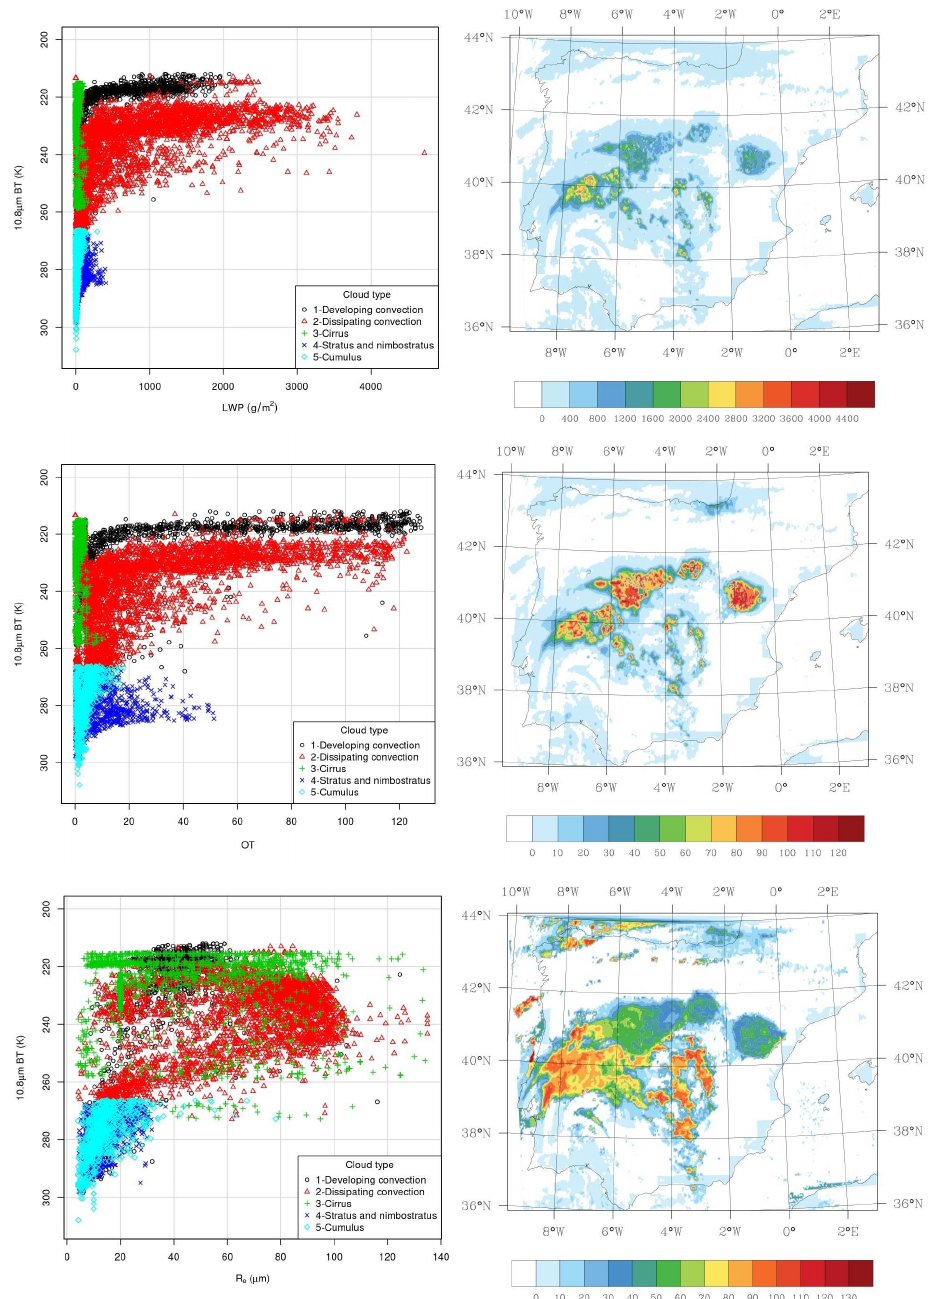
25 Fig. 3. Left: scatter plot of LWP (top), OT (middle) and R e (bottom) values as a function of 10.8µm BT for the cloud types at 14:00UTC, Fig. 3. Left: Scatter plot of LWP (top), OT (middle) and R e (bottom) values as a function of 10.8- µ m BT for 12 August 2011. Right: LWP (top), OT (middle) and R e (bottom) over the Iberian Peninsula. the cloud types at 1400 UTC, 12 August 2011. Right: LWP (top), OT (middle) and R e (bottom) over Iberian Peninsula. – Channels at 6.2 and 7.3 µm, and their interaction troposphere. These channels are also important when (channel 6.2 µm × channel 7.3 µm): emission in this computing atmospheric corrections (Minnis et al., part of the spectrum occurs within the water va- 1995). The 7.3 µm channel and its interaction with the por (WV) absorption band. The channel at 6.2 µm 6.2 µm channel are the greatest weight in the equation is sensitive to WV emittance in the upper tropo- (Wald parameter in Table 2). Cumulonimbus clouds sphere, and that at 7.3 µm to emittance in the mid- are the only ones often extending through the